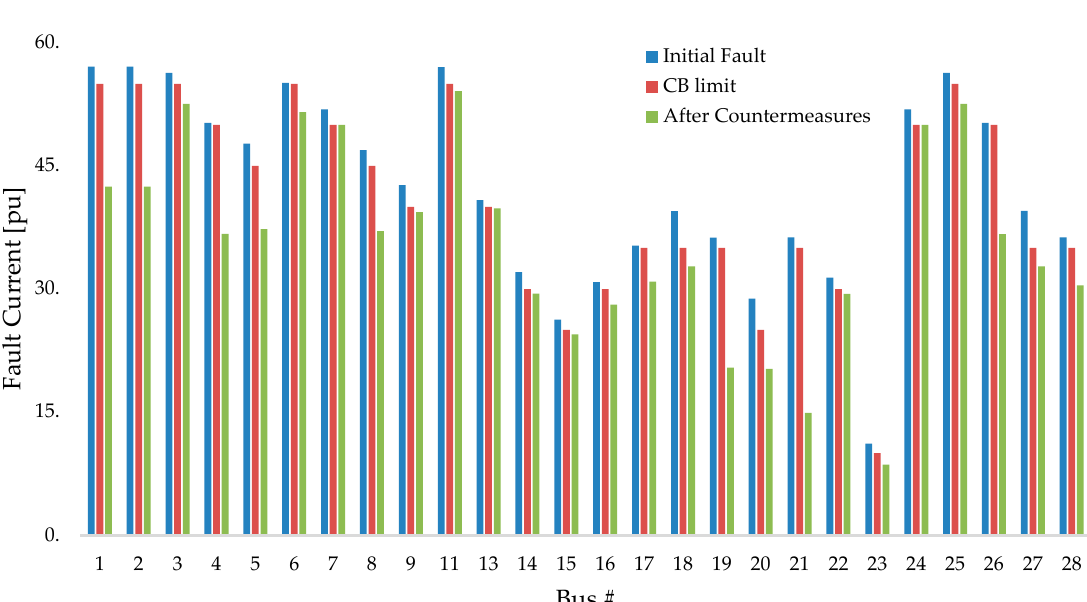
Figure 9. Countermeasures and their corresponding least membership function values.